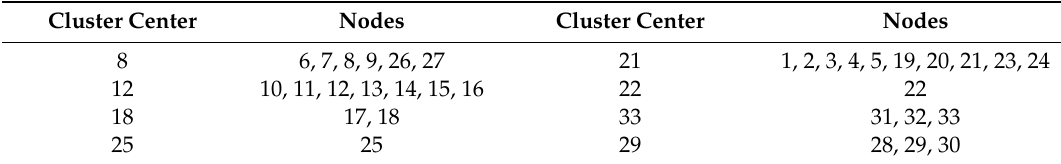
Figure 4. Decision graph with four SOPs integrated in the system. Table 2. Detailed distribution result of nodes. Table 2. Detailed distribution result of nodes.